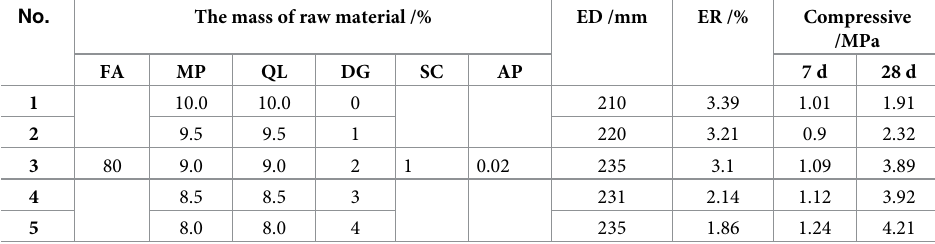
Table 3. Influence of desulfurized gypsum amount on material performance. No.